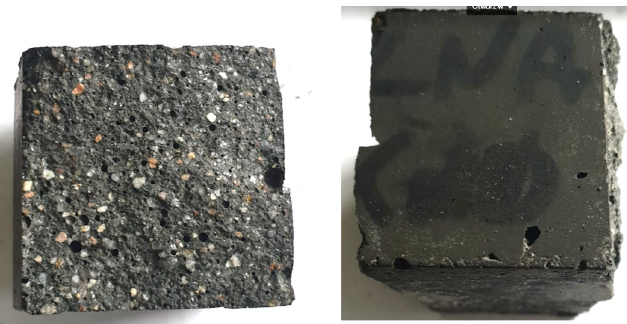
Figure 9. The view of pores of glass wool-based geopolymer mortar with Al 2 O 3 . The average compressive strength of their binders (tested on 20 mm × 20 mm × 160 mm samples, Figure 10) was about 20 MPa (in the case of glass wool-based geopolymer with bauxite). It was observed that samples of geopolymeric binders without aggregate participation are characterised by cracking and deformation of samples due to shrinkage. The reason was that the samples were too slender. The shrinkage value is greatly influenced by the geometry of the samples, especially without aggregate. The compressive strength of binders with AL 2 O 3 was about 25 MPa.